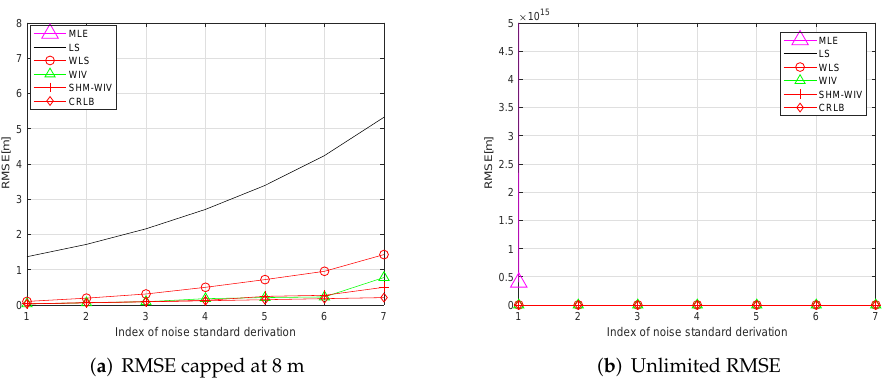
Figure 8. ( a ) RMSE versus noise with randomized source location (RMSE is capped at 8 m); ( b ) RMSE versus noise with randomized source location (MLE is missing in ( a ) as it diverges for entire noise